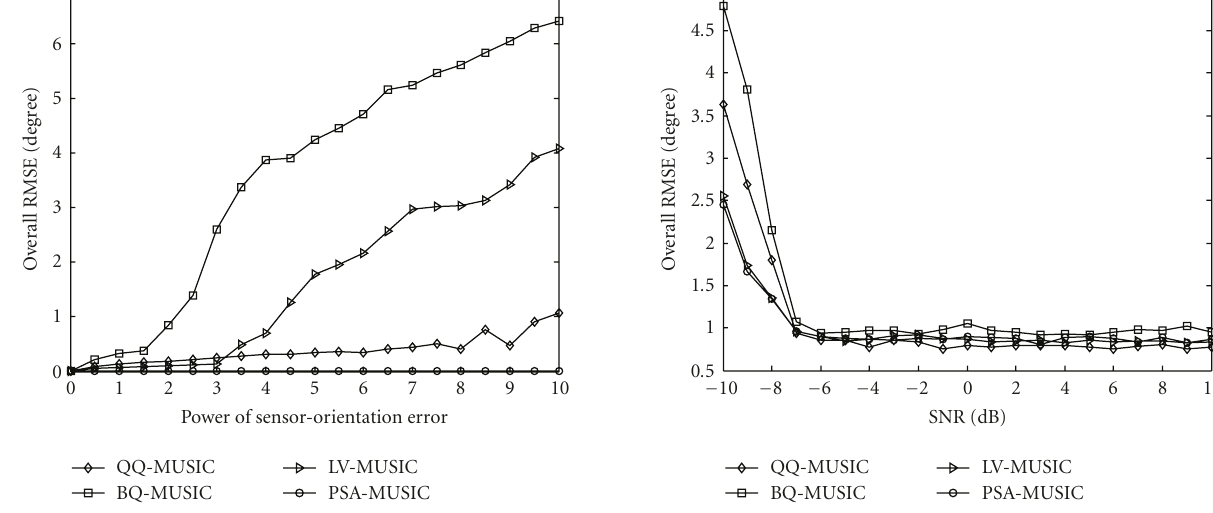
Figure 8: RMS estimation errors versus SNR in the presence of sensor position errors.